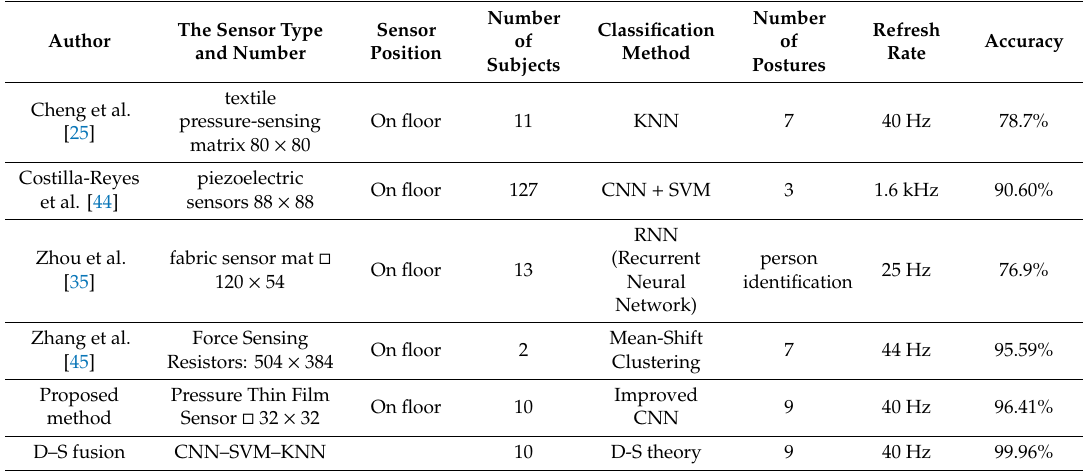
Table 5. Comparison between the reported studies and proposed